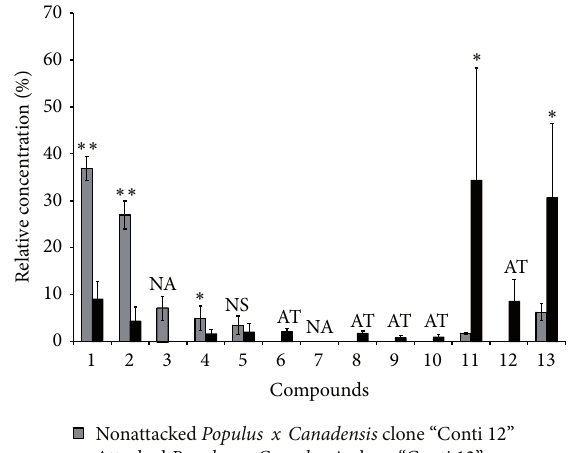
Figure 5: Volatile organic compounds emitted by attacked and nonattacked Populus x canadensis clone “Conti 12.” The numbers represent the major compounds, 1: 𝛽 -selinene, 2: 𝛼 -selinene, 3: 𝛽 - chamigrene, 4: 𝛽 -elemene, 5: salicylic aldehyde, 6: 𝛽 -cubebene, 7: 𝛽 - sesquiphellandrene, 8: 𝛼 -gurjunene, 9: 𝛿 -cadinene, 10: 𝛼 -ylangene, 11: 𝛼 -copaene, 12: aldehyde of Rt 20.57 , and 13: aldehyde of Rt 21.82 . The area normalization performed only on identified compounds and the values are the mean of four replicates ± SD. NS: not significant differences between relative concentration in attacked and non- attacked plants ( 𝑃 > 0.05 ). ∗ and ∗∗ : relative concentration in the attackedplantsissignificantlydifferent( 𝑃 < 0.05 )orhighlydifferent ( 𝑃 < 0.01 ) respectively, from non-attacked plants (ANOVA-Tukey HSD mean multiple comparison test). AT: compounds only present in attacked plants and NA: only present in nonattacked